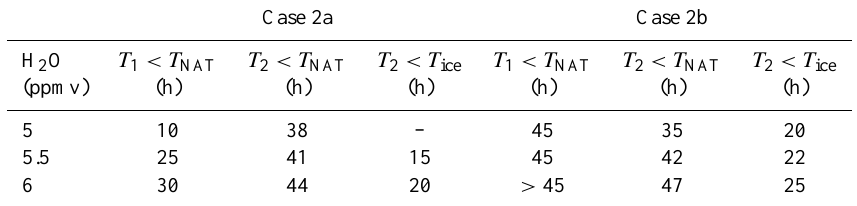
Table 2. Time periods when T 1 and T 2 are below the NAT and ice threshold temperature along the trajectory. T NAT and T ice were derived for H 2 O mixing ratios of 5, 5.5. and 6ppmv for the back trajectory started on 23 January 2011 at 20:00UTC (Case 2). Water vapour increases (Case 2a) as well as an additional temperature cooling by 1K (Case 2b) are